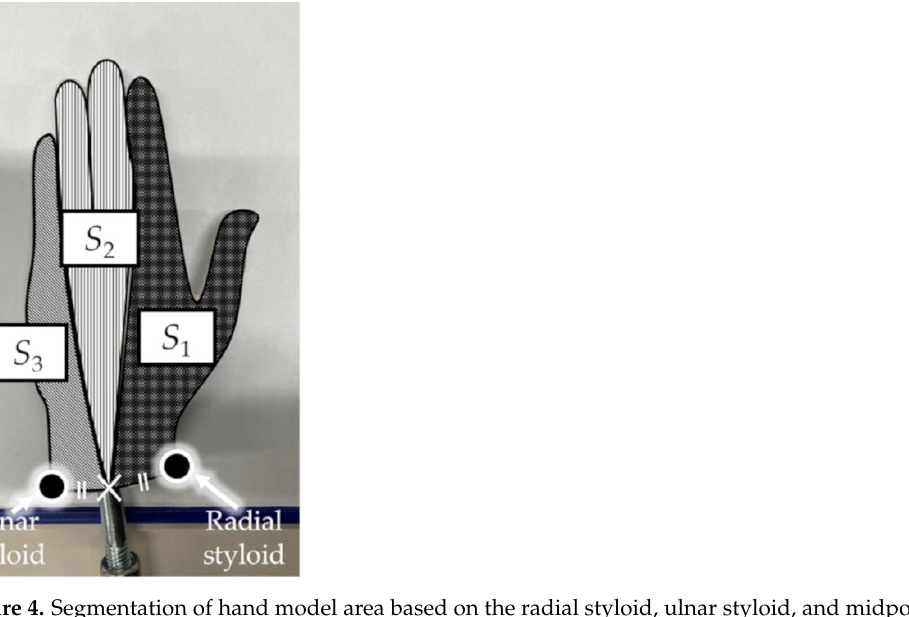
Figure 4. Segmentation of hand model area based on the radial styloid, ulnar styloid, and midpoint of two points.